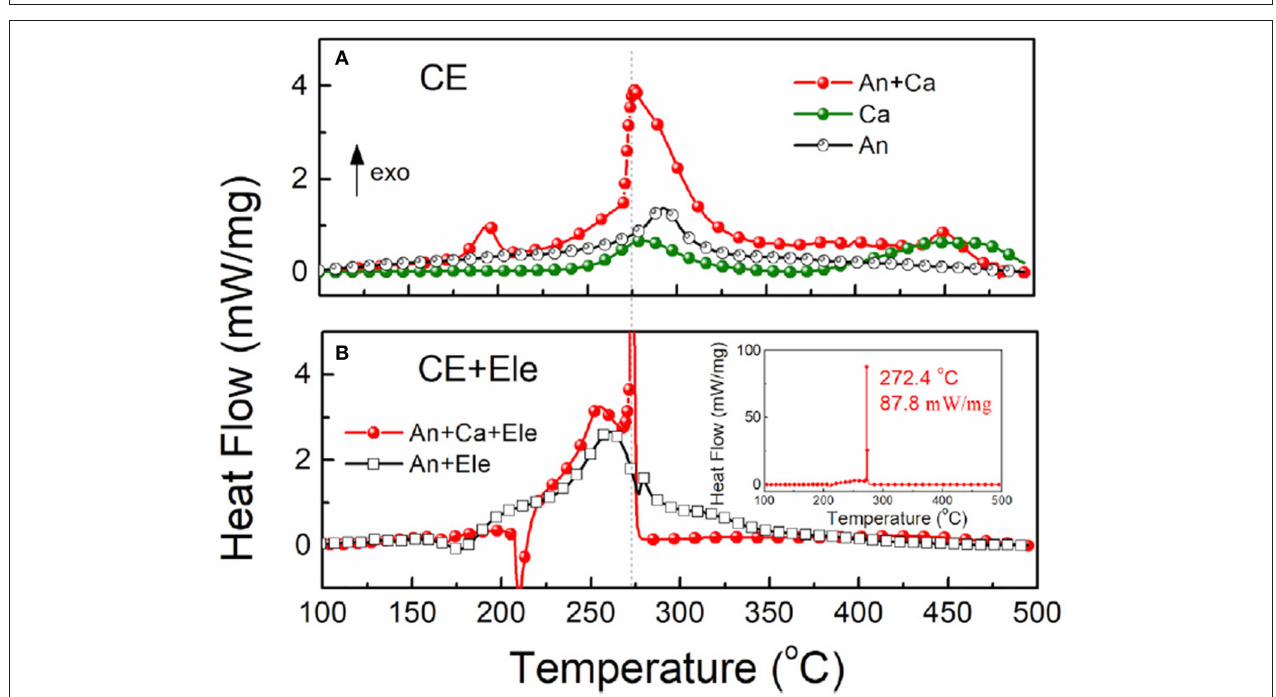
FIGURE 8 | The heat generation of the charged battery components by DSC measurements. (A) Charged electrode (CE) without electrolyte. (B) Charged electrode with electrolyte. An, anode; Ca, cathode; Ele, electrolyte; CE, charged electrode. Reprinted from Liu et al. (2018e). Copyright (2018), with permission from